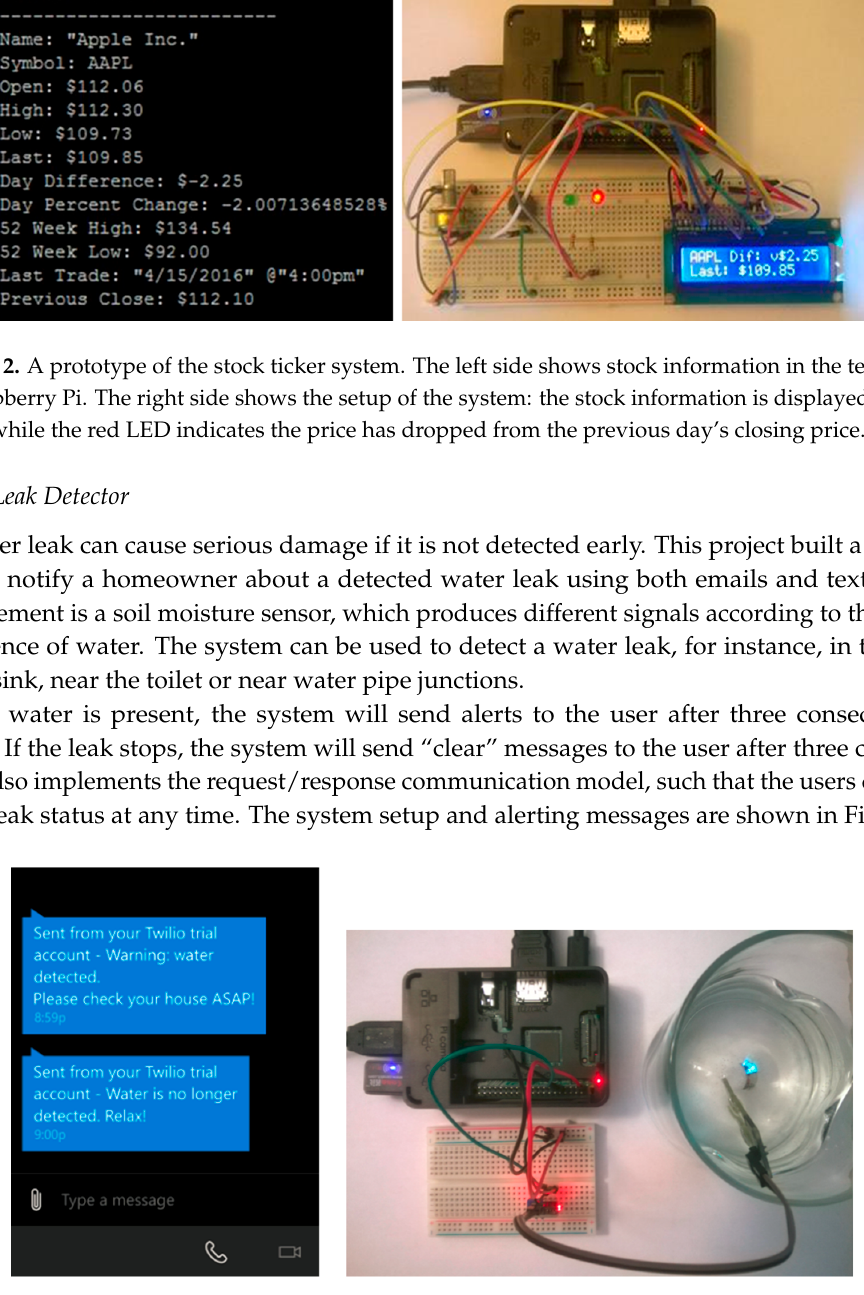
Figure 3. The prototype of the water leak detector. When a water leak is detected, email and text messages are sent to the user. When the water leak stops, updated email and text messages are sent to the user.